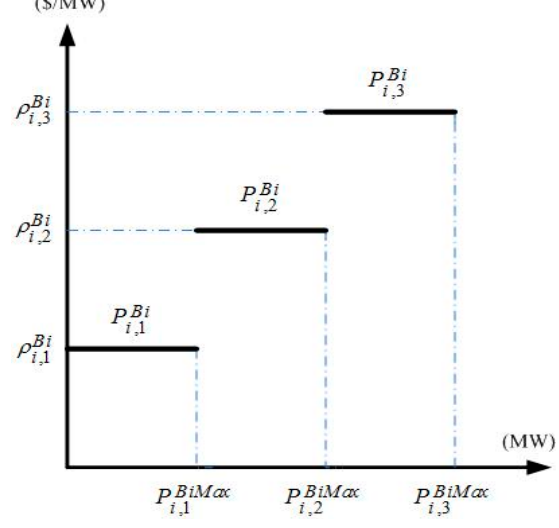
Figure 1. Offer curve of bilateral contracts.